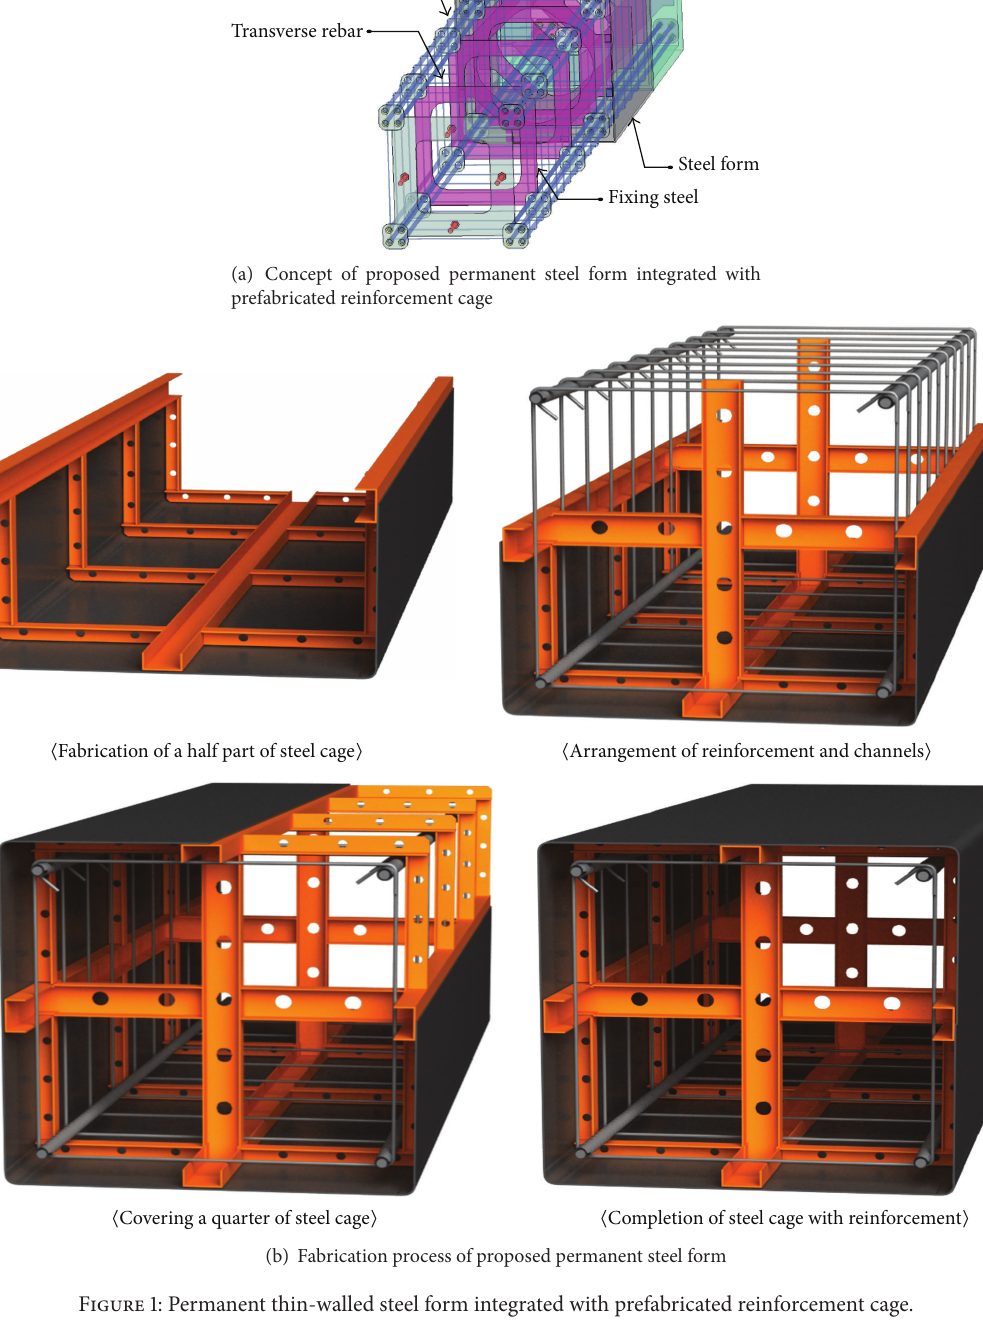
Figure 1: Permanent thin-walled steel form integrated with prefabricated reinforcement